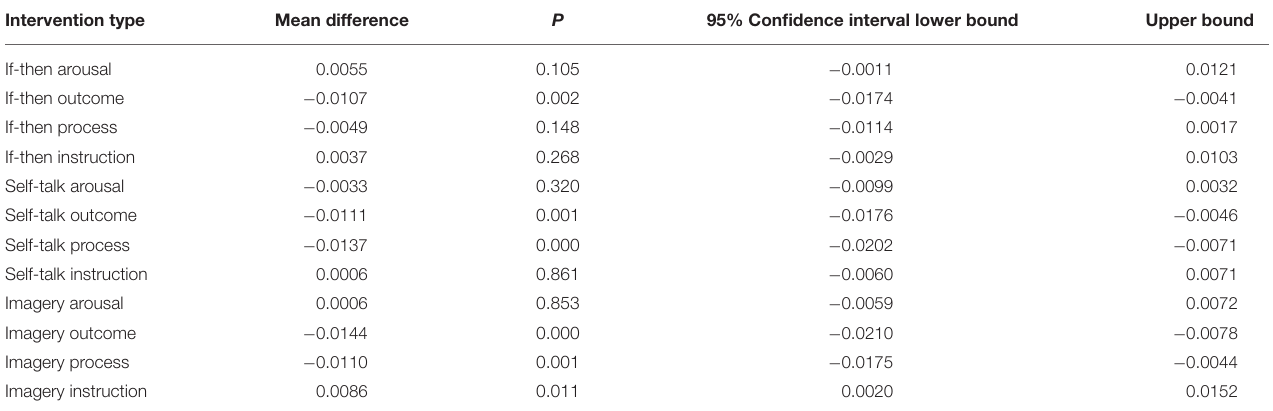
TABLE 4 | Differences between the intervention and control